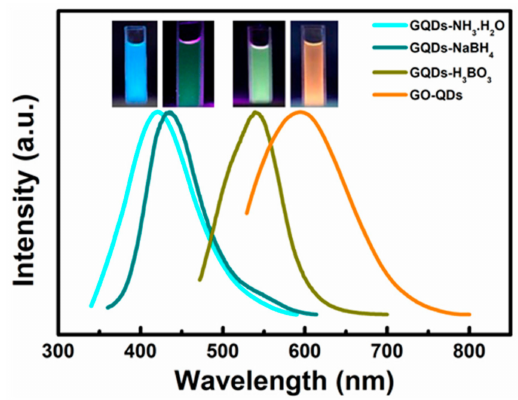
Figure 7. PL spectra of GO-QDs, GQDs-NH 3 · H 2 O, GQDs-NaBH 4 and GQDs-H 3 BO 3 excited at 323 nm. The insets are their corresponding digital photographs ( λ ex = 365 nm).